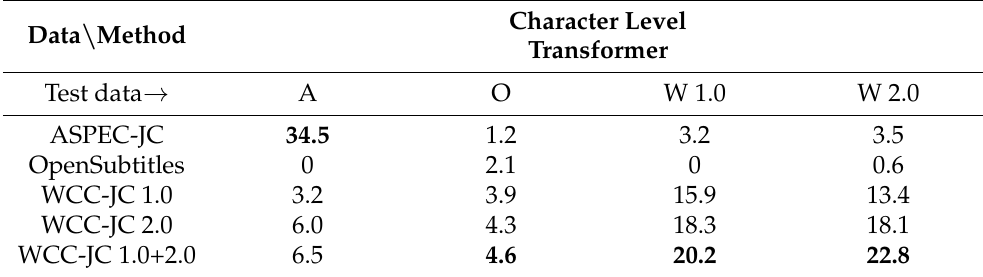
Table 8. Results of Japanese → Chinese translation experiments at character level (BLEU scores).